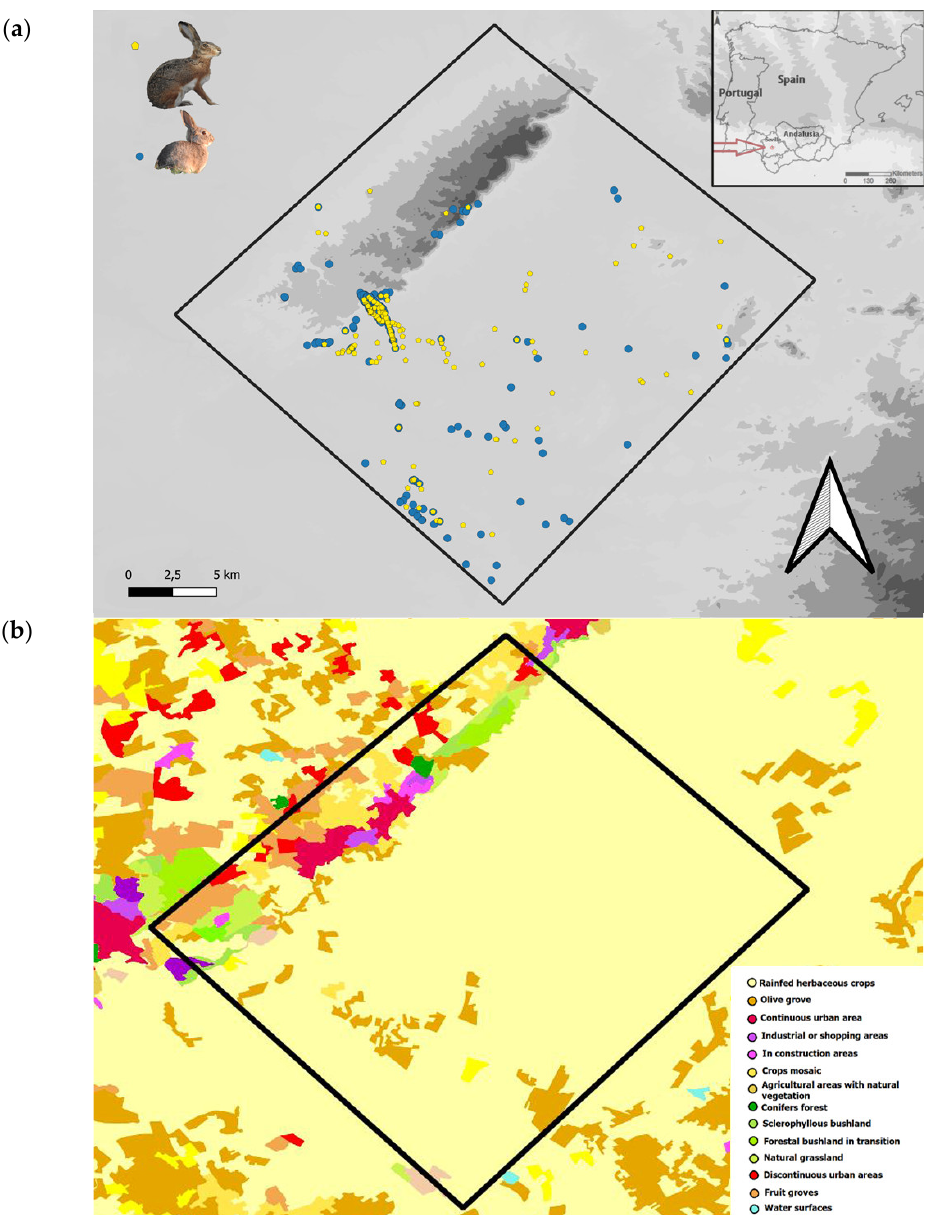
Figure 1. Map of “Vega de Carmona”, “Los Alcores”, and surrounding area in the province of Seville (S. Spain). The box marks the study area. ( a ) Dots represent the recorded localities of Iberian hares (yellow) and rabbits (blue) over the digital elevation model layer. ( b ) Land uses of the study area.